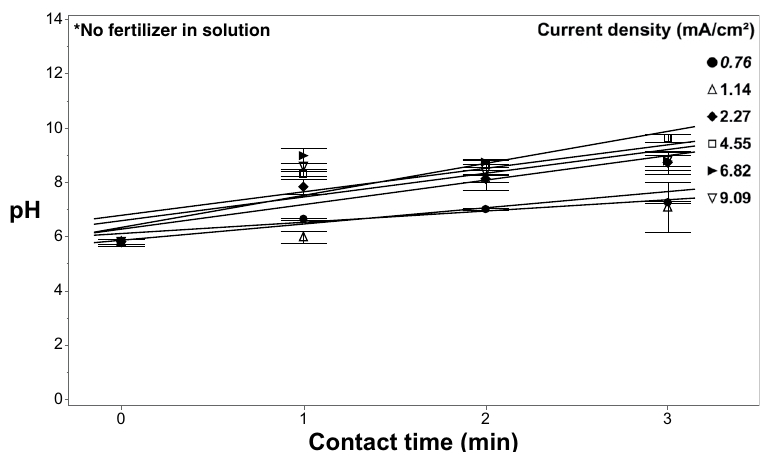
Figure 6. The pH of the solution during treatment as a function of current density and contact time with 20 mg/L of chloride in solution with no fertilizer present. Error bars are ± SEM, N =